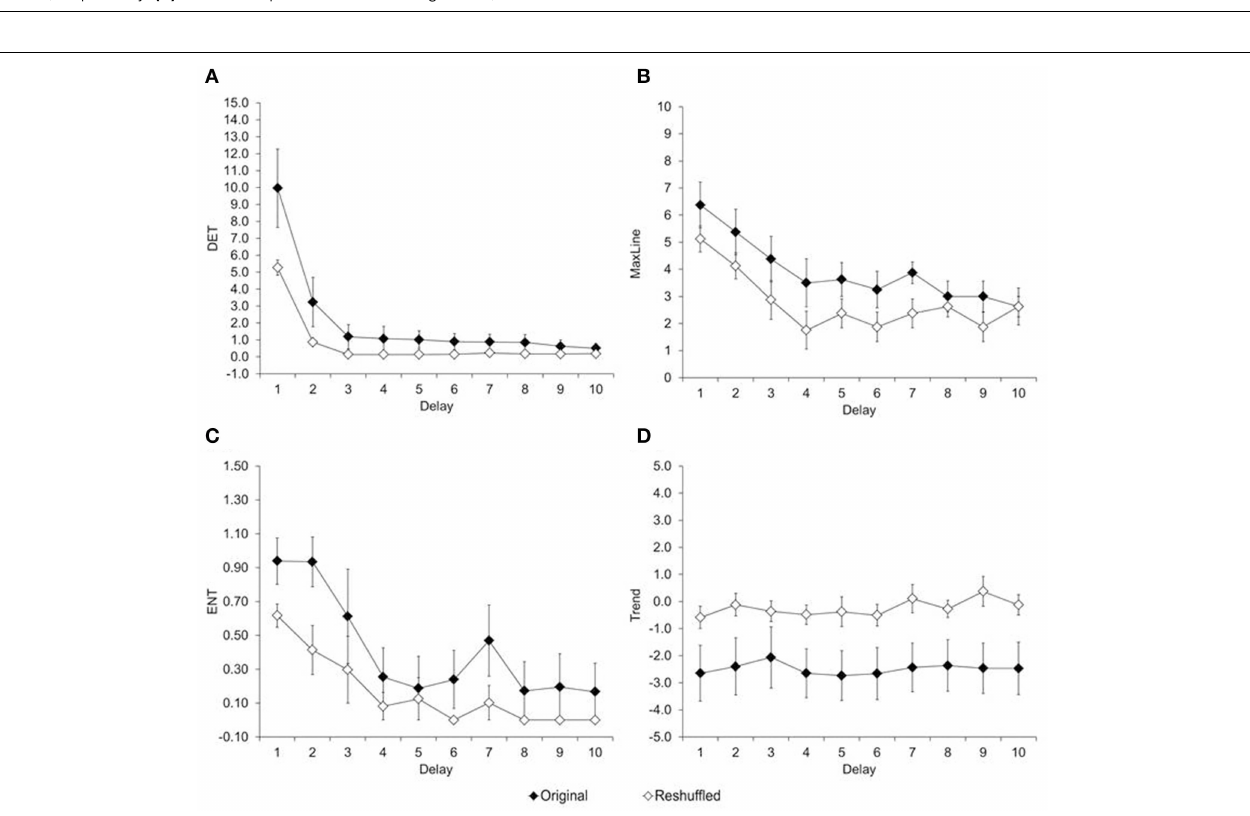
FIGURE 7 | (A) Difference between the Hurst exponents determined for the original time series and the reshuffled time series, shown as a function of participants’ age. Asterisks show the average difference for children and adults, respectively. (B) Cumulative plots of subset size against Q, in